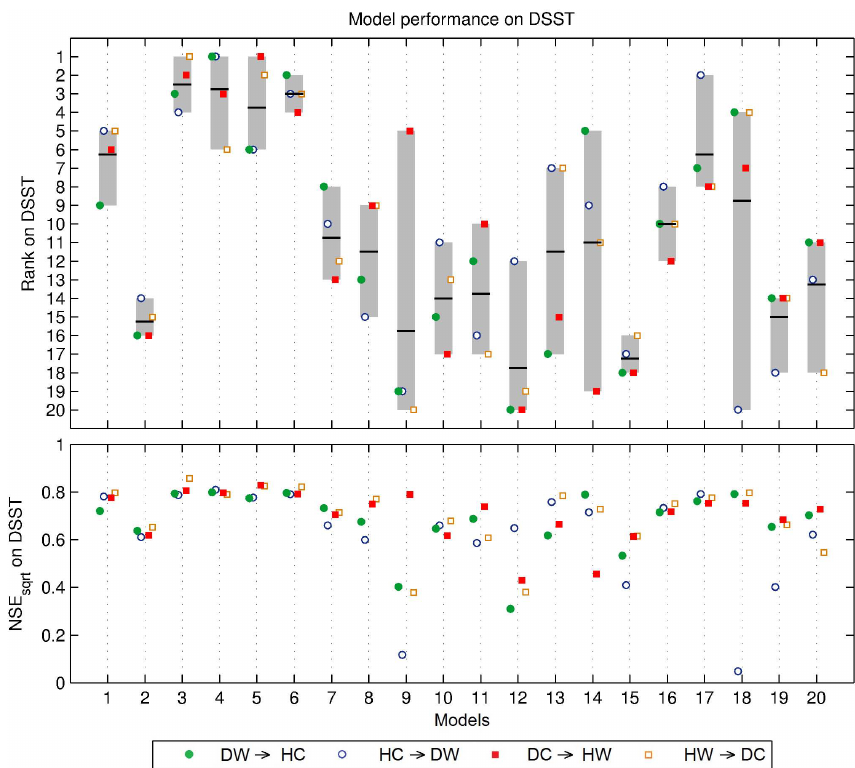
Fig. 8. Performance and rank in validation (NSE sqrt criterion) for the four DSST on the Schlehdorf catchment